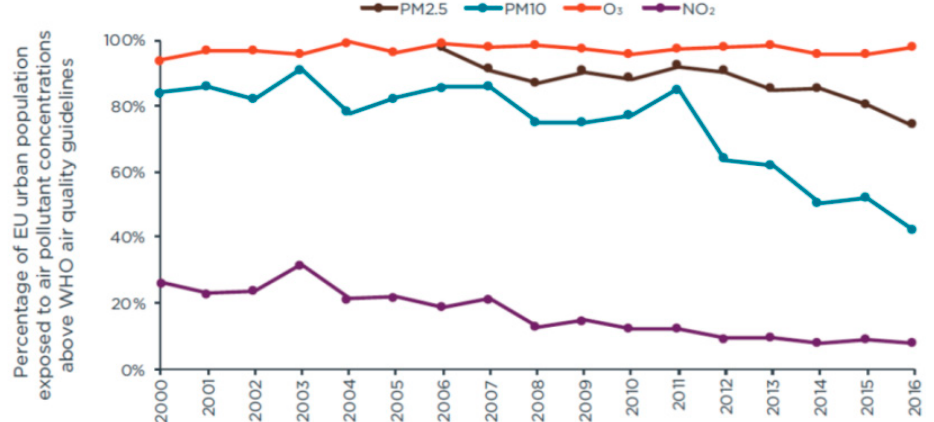
Figure 5. Percentage of EU urban population exposed to air pollutant concentrations above WHO air quality guidelines [11].